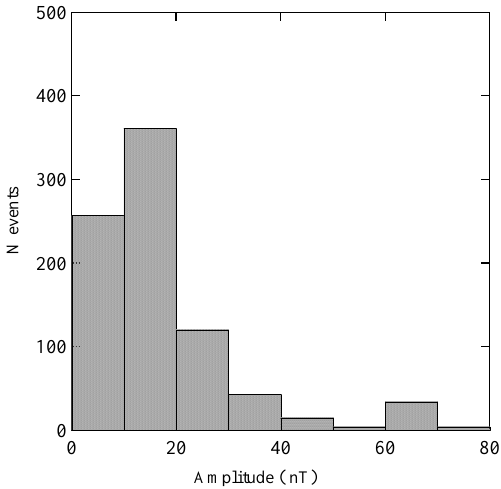
Fig. 6. A histogram of Interball-1 FTE amplitudes. The mean and median values are 15 and 13nT,